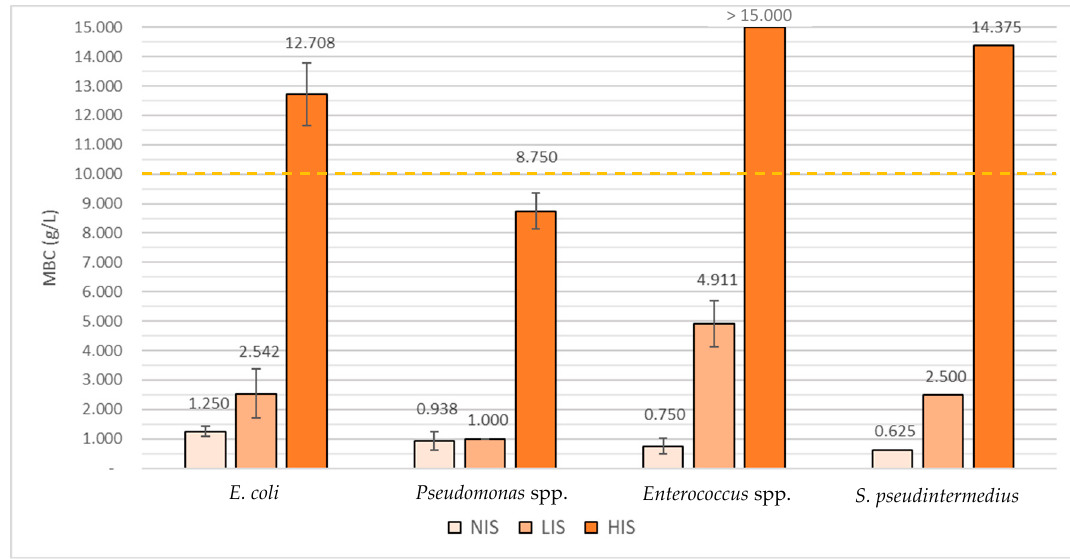
Figure 1. Virkon ® S’s of MBCs mean values obtained in the assays with no interfering substance (NIS), low interfering substance (LIS), and high interfering substance (HIS) towards the different groups of isolates (grams per liter). - - - Concentration used in the BICU.